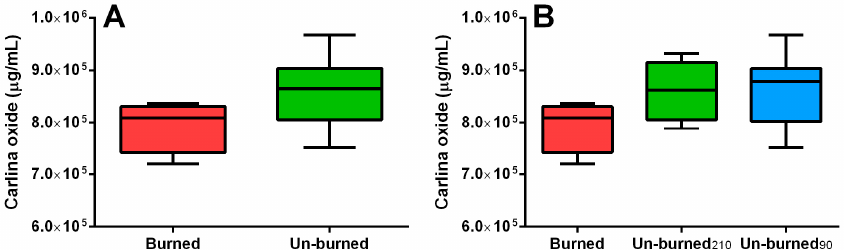
Figure 4. Box plots showing carlina oxide content value distributions for burned and un-burned samples ( A ) and for burned vs. un-burned samples subject to microwave irradiation for 90 or 210 min ( B ). The two groups in panel A were compared with an unpaired t -test, while the three groups in panel B were compared with ANOVA. The significance was reported in terms of the p -value as follows: no asterisks for p > 0.05; * for 0.05 < p < 0.01; for ** 0.01 < p < 0.001; *** for p < 0.001. The horizontal line within the box is the median value, while the whiskers represent the maximum and minimum values recorded; the top of the rectangle indicates the third quartile, while the bottom of the rectangle indicates the first quartile.